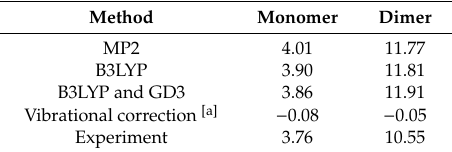
Figure S3: Temperature dependence of the half width of the 1 H–NMR signal of acetic acid COOH group in the glass insert. Figure S4: Temperature series of 1 H–NMR spectra of acetic acid (c = 1.1 mM) in the glass insert. Figure S5: Temperature series of 1 H–NMR spectra of acetic acid (c = 4.4 mM) in the glass insert. Figure S6: Temperature series of 1 H–NMR spectra of acetic acid (c = 7.9 mM) in the glass insert. Figure S7: Pressure dependence of the chemical shift difference of acetic acid in the FEP insert. Table S2: Optimized thermodynamic parameters of dimerization and the chemical shift difference of the dimer obtained from the measurements of acetic acid in the FEP insert. Figure S8: Complete basis set limit of correlation energy of acetic acid monomer and dimer. Table S3: Computed energy values used for the CBS extrapolation. Table S4: Calculated values of dimerization energies of acetic acid at different computational levels. Table S5: Cartesian coordinates of the acetic acid monomer optimized at the MP2 / Aug-cc-pVQZ level. Table S6: Cartesian coordinates of the acetic acid dimer optimized at the MP2 / Aug-cc-pVQZ level. Figure S9: Distribution of chemical shifts of acetic acid monomer and dimer (bottom) during the PIMD simulation. Figure S10: Correlation between B3LYP calculated chemical shift and O-H distance in the dimer of acetic acid. Table S7: B3LYP calculated 1 H chemical shieldings (ppm) and vibrational corrections based on the PIMD